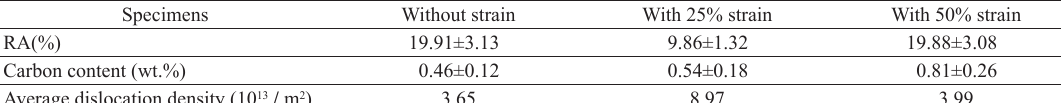
Table 1. The volume fractions and carbon contents of RA and the average dislocation density in different